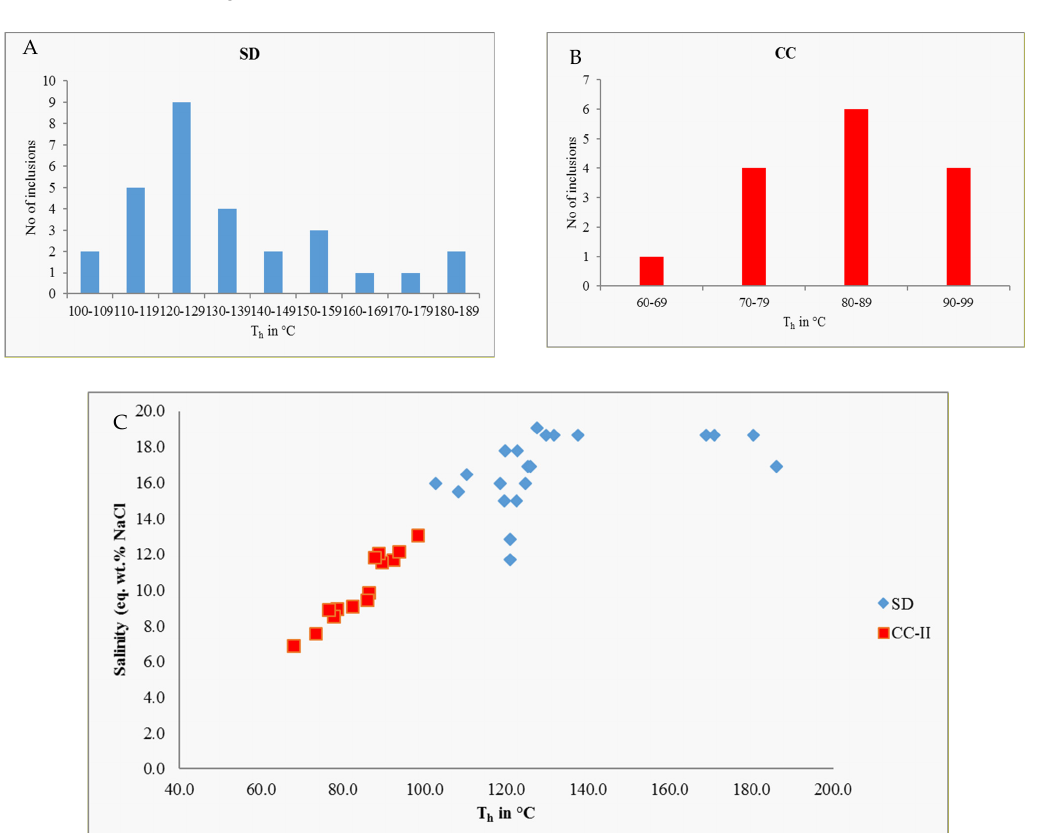
Figure 10. Fluid inclusion data of the saddle dolomite and fracture-filling calcite. ( A ) histogram showing the homogenization temperature of saddle dolomite. ( B ) histogram showing the homogenization temperature of fracture-filling calcite. ( C ) homogenization temperature versus salinity data of saddle dolomite (SD) and fracture-filling calcite (CC). As most of the inclusions are small in size, low-temperature phase changes could not be identified. The only measurable reading of both saddle dolomite and vein calcite is the last ice melting (T mi ). The T mi of saddle dolomite ranges from − 15.5 °C to − 8.0 °C (average − 13.4 °C), and fracture-filling calcite between − 9.2 °C and − 4.3 °C (average − 6.8 °C) (Figure 10C; Table 3). The T mi values are used to calculate the salinity of fluids by using the rela- tionship of Bodnar (1993). The salinity of saddle dolomite (SD) ranges between 11.7 and 19.4 eq. wt.% NaCl (average 17.1 eq. wt.% NaCl), and fracture-filling calcite between 6.9 and 13.1 eq. wt.% NaCl (average 10.1 eq. wt.% NaCl) (Figure 10C; Table 3). 5. Discussion 5.1. Origin of Dolomite Phases Field and analytical results revealed that two distinct dolomitization episodes af- fected the platform carbonates of the Samana Suk Formation. Field evidence indicates that matrix dolostone (RD-I) occurs as strata-bound units. The dolomite bodies, which are formed during or soon after deposition, may retain ge- ometries similar to the original depositional geobodies; hence they are often called strata- bound or stratiform dolomites (Figure 3D). Patchy replacive dolostone (RD-II) field ge-